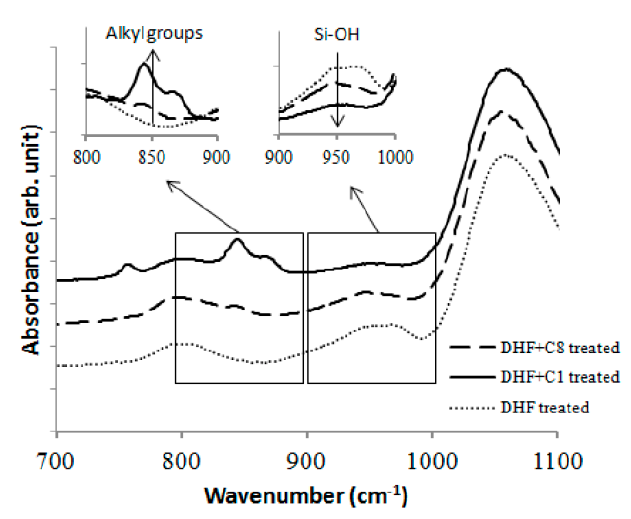
Figure 39. ATR-IR spectrum measured from silicon oxide powder treated with C1 or C8 shows that C1 has better result because of higher hydrocarbon groups around 750 to 900 cm − 1 , while lower hydroxyl group at 960 cm − 1 [243].